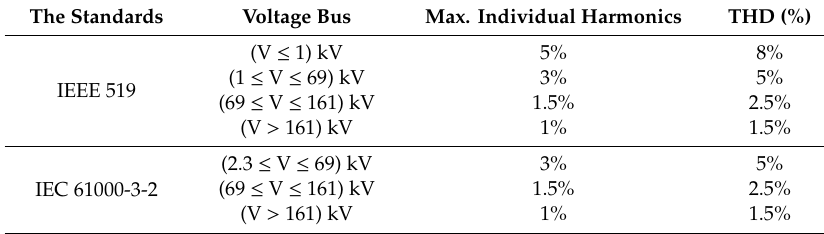
Table 3. Voltage harmonics distortion limits of the PV